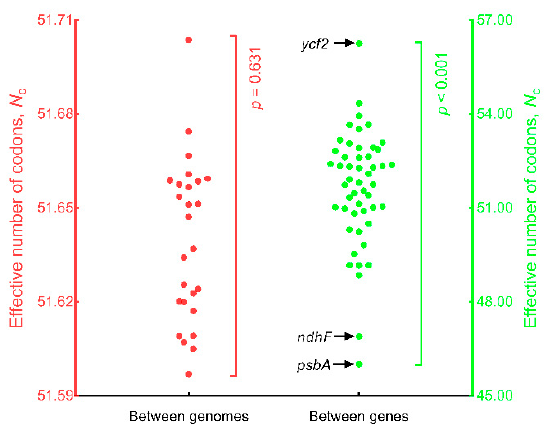
Figure 4. Comparison of effective number of codons ( N c ) between genomes and between genes. The 26 red solid circles represent the mean N c values ( n = 50) for each of the 26 genomes and are plotted on the left y-axis. The 50 green solid circles represent the mean N c values ( n = 26) for each of the 50 genes and are plotted on the right y-axis.